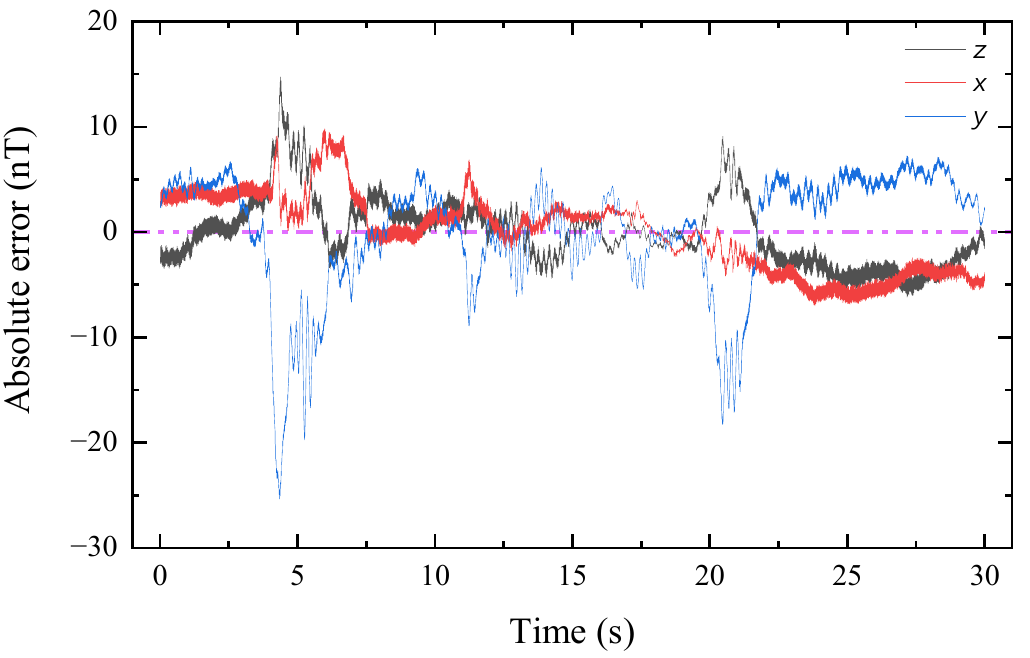
Figure 10. Absolute error diagram of ambient magnetic field in three axes.